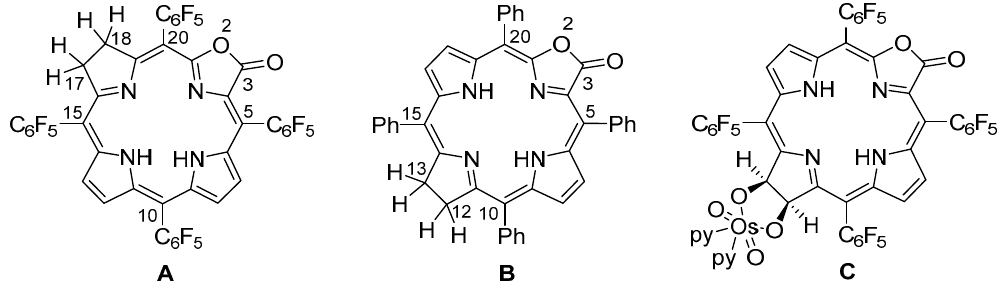
Figure 1. Known dihydroporpholactones structurally related to cycloadducts 3 and 6 / 7